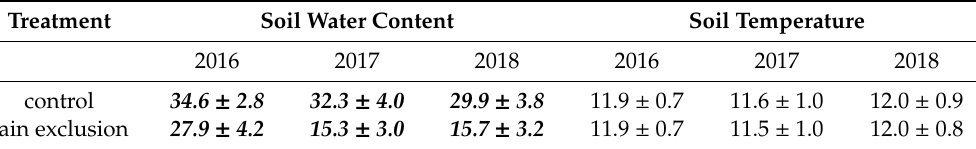
Table 3. Seasonal mean soil water content (vol %) at a 5–10 cm soil depth and soil temperature ( ◦ C) at a 10 cm soil depth in control and rain exclusion plots for the periods 16 August–3 October 2016, 18 May–13 September 2017, and 23 May–23 September 2018. Values are the mean ± SE of three sensors per treatment. Significant di ff erences ( p < 0.1) between control and rain exclusion plots are marked in bold and italics.